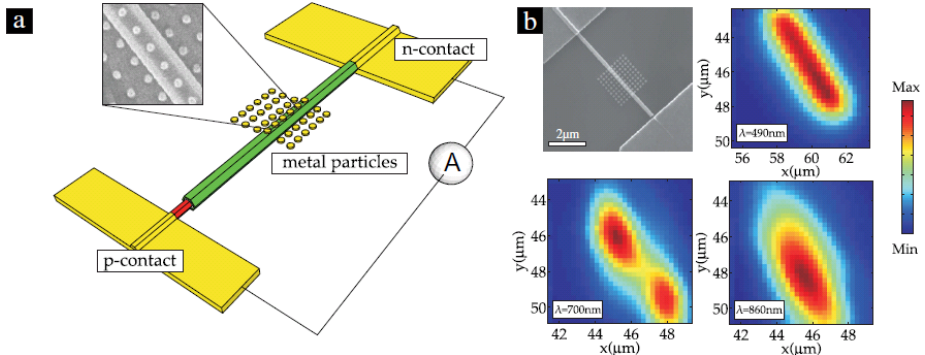
Figure 9. ( a ) Illustration of a contacted radial p–i–n junction GaAs NW. ( b ) A SEM image of a typical device is shown in the top left corner of the picture. The other images show examples of photocurrent maps. Reprinted with permission from [64]. Copyright © IOP